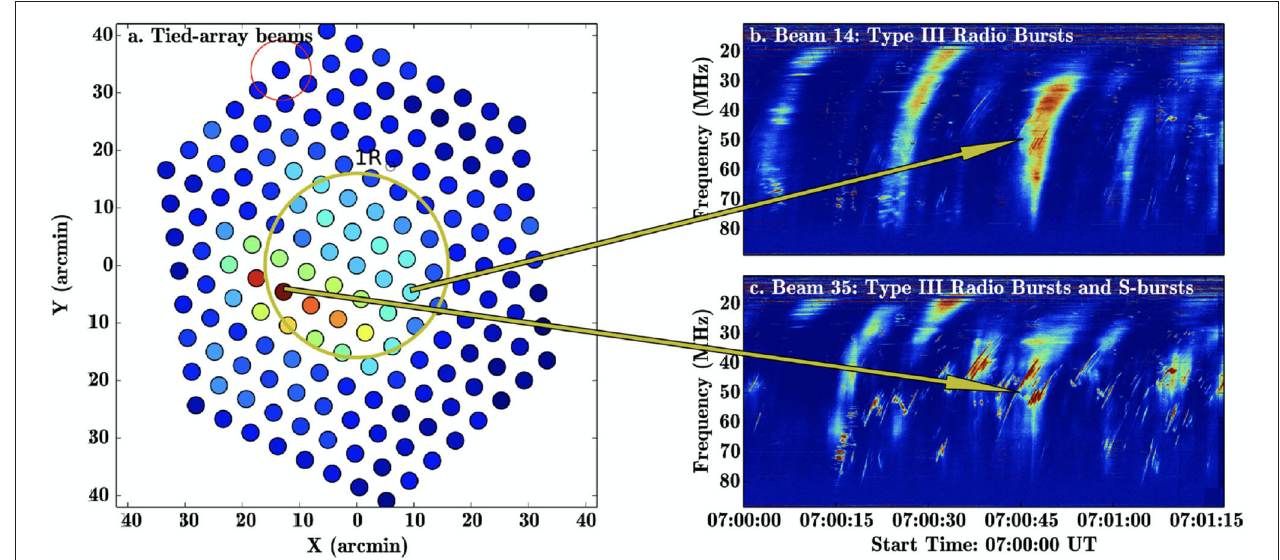
FIGURE 1 | LOFAR tied-array beam observations of Type III radio bursts and solar S bursts. Left : The 170 tied-array beams covering a field-of-view of about 1.3 degrees about the Sun. Right : Two dynamic spectrum highlighting different solar activity coming from different regions in the solar disc. From Morosan et al. (2015).